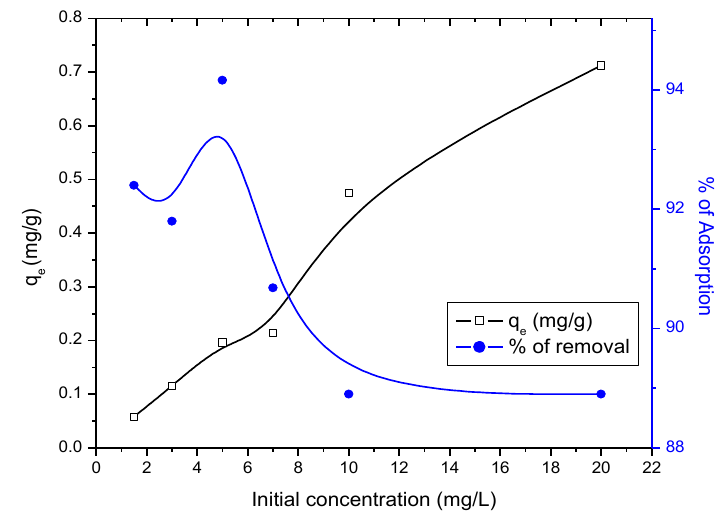
Figure 9. Effect of Initial concentration on the adsorption of fluoride by eggshell powder (experimental conditions: pH: 6.0, adsorbent dose: 2.4 g/100ml and particle size 150µm, agitation speed: 350 rpm, contact time: 100 minutes, Temperature: 303